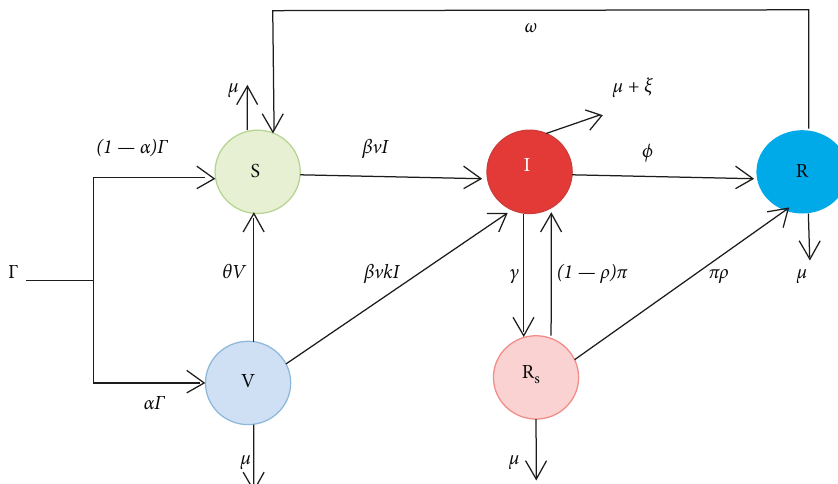
Figure 1: Schematic diagram of model